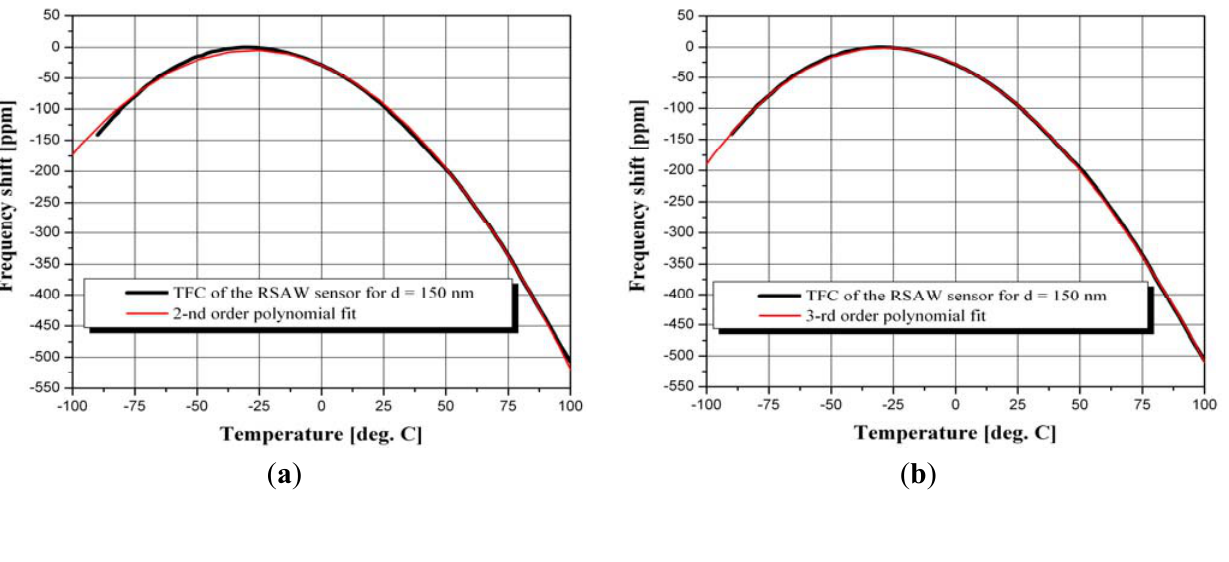
Figure 9. ( a ) Experimental (black) and second order polynomial fit (red) of the TFC data from the 150 nm HMDSO polymer coated RSAW device and ( b ) the same data plot (black) but interpolated with a third order polynomial fit